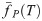
Ineffective selection due to community function measurement noise can be rescued by the top-tier strategy acting in synergy with cell sorting.Adult communities were chosen to reproduce based on "measured community function P(T)"—the sum of actual P(T) and a "noise term" randomly drawn from a normal distribution with zero mean and standard deviations of 5% or 10% of the ancestral P(T). Dynamics of average fP and average community function of the chosen Adult communities (f¯P(T) and P¯(T)) are plotted. When community function measurement noise is low (5%), cell sorting largely rescues ineffective community selection (A–D, left panels). When community function measurement noise is high (10%), both cell sorting and top-tier strategy are required (A–D, right panels). Black, cyan, and gray curves represent independent simulation trials. P¯(T) was averaged across the chosen Adults. f¯P(T) was obtained by first averaging among M within each chosen Adult and then averaging across the chosen Adults. The simulation codes can be found in S3 Code, and the data can be found in S2 Data. Adult, Adult community; M, Manufacturer.